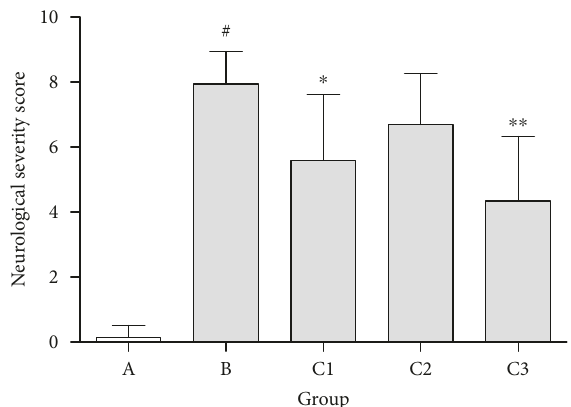
Figure 2: Neurological severity score of each group following CIRI for 5 days. # P < 0 01 versus group A; ∗ P < 0 05 , ∗∗ P < 0 01 versus group B. Group A: sham-operated; group B: control; group C1: pretreatment; group C2: treatment; group C3: pretreatment +